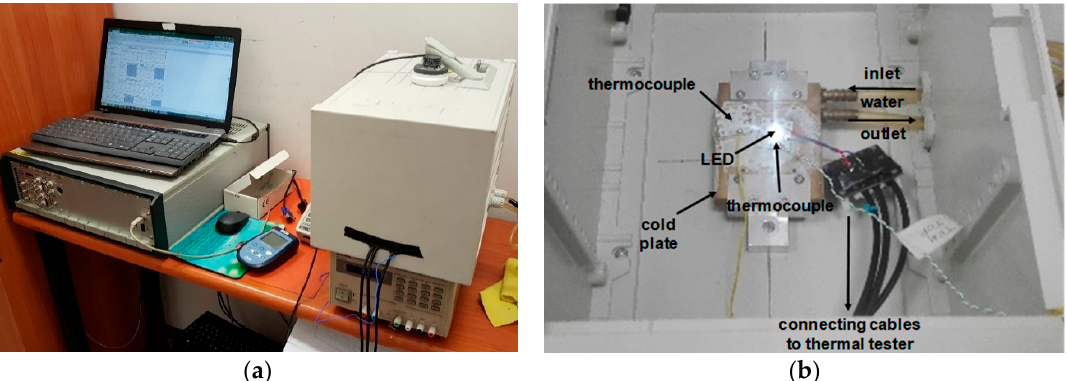
Figure 1. ( a ) View of the measurement equipment; ( b ) the interior of the light-tight chamber with the cold plate and a power LED [29].